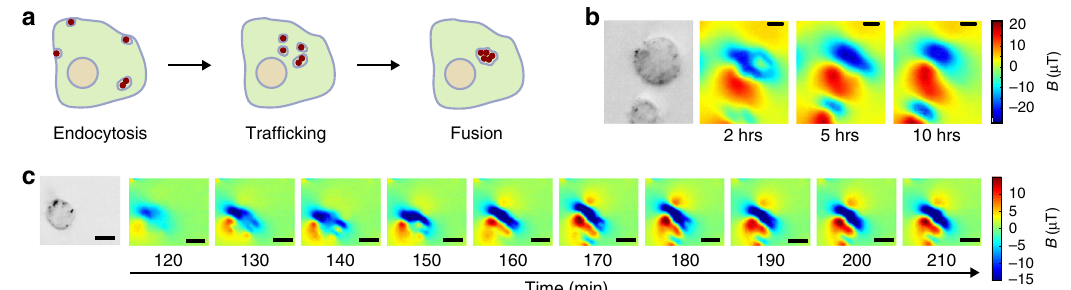
Fig. 4 Dynamic magnetic microscopy in live mammalian cells. a Cartoon showing the typical progression of endocytotic uptake of IONs. b Bright fi eld and series of time-lapse magnetic fi eld images of RAW macrophages over 10 h. Three additional replicates are shown in Supplementary Fig. 7. c Bright fi eld and series of time-lapse magnetic fi eld images of a RAW macrophage with 10 min between magnetic fi eld images. Two additional replicates of this experiment are shown in Supplementary Fig. 7. Scale bars are 5